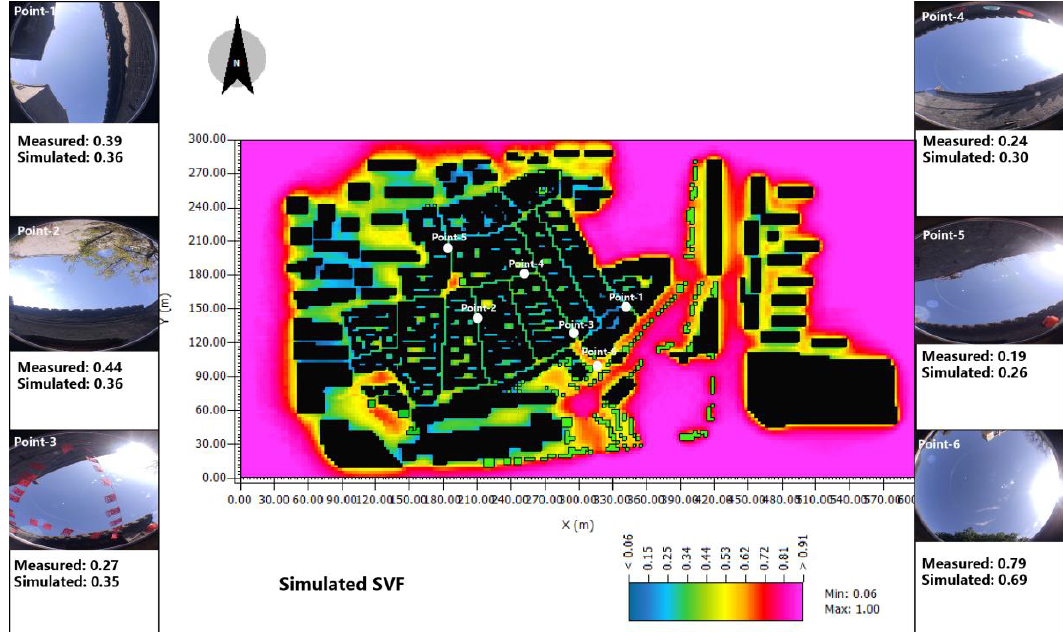
Figure 5. The validation between measured and simulated sky view factor (SVF) [18].